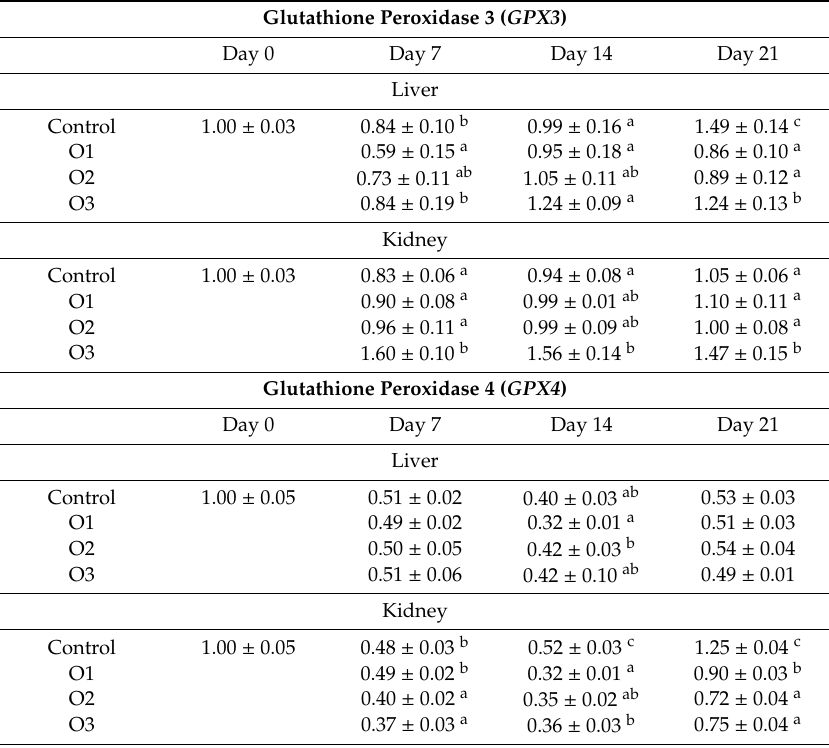
Table 8. E ff ect of Ochratoxin A treatment on the relative expression of GPX3 , GPX4 genes in liver and kidney of broiler chickens (mean ± SD; n = 6 in a pool, equal amounts of cDNA per